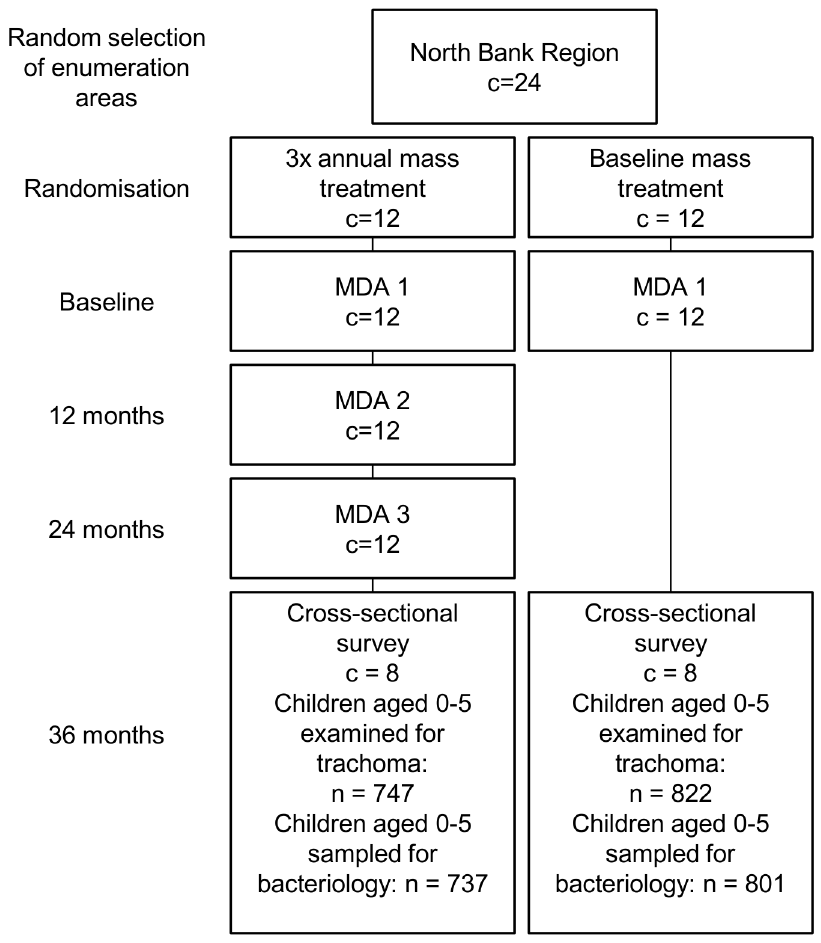
Figure 1. Study allocation.